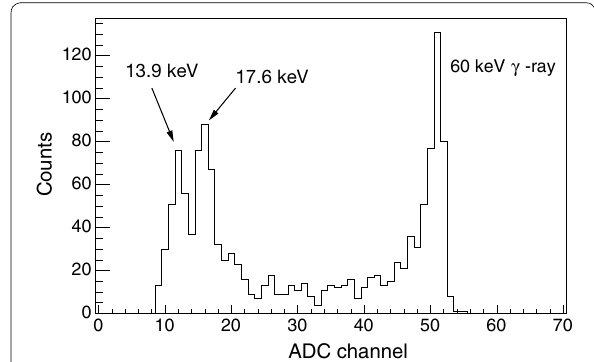
Fig. 8 γ-ray spectrum obtained by HEP SSD recorded with 241 Am radioactive